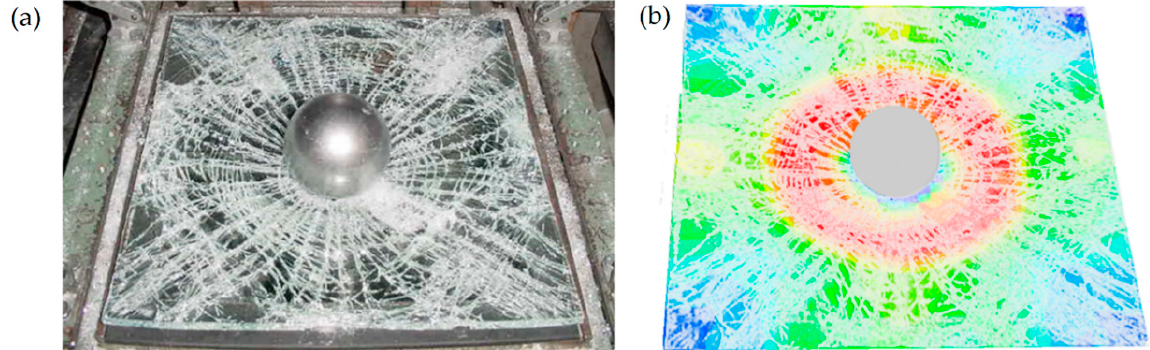
Figure 6. Results comparison for ( a ) experimental tests and ( b ) numerical analyses for samples from Test no. 1.